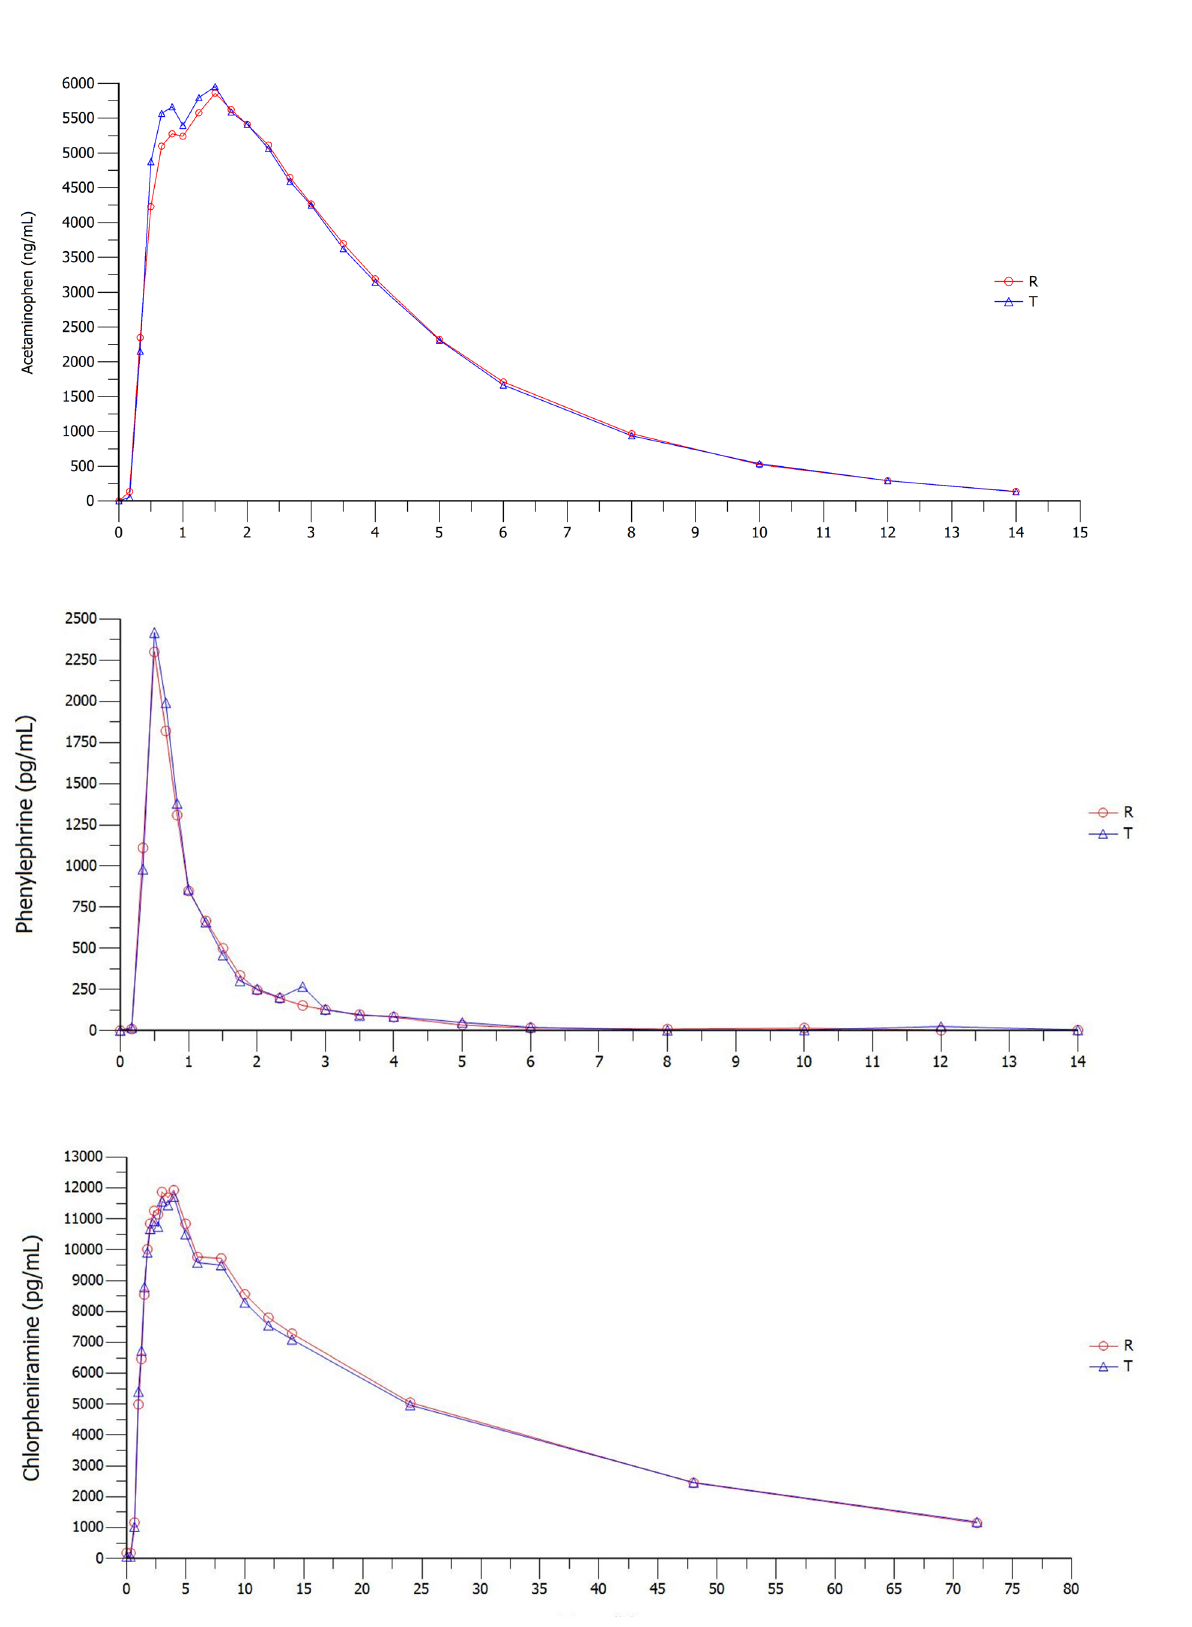
FIGURE 1 - Average plasma concentrations versus time profile obtained after a single oral administration of drugs containing acetaminophen (A), maleate of phenylephrine (B) and chlorpheniramine (C) in healthy